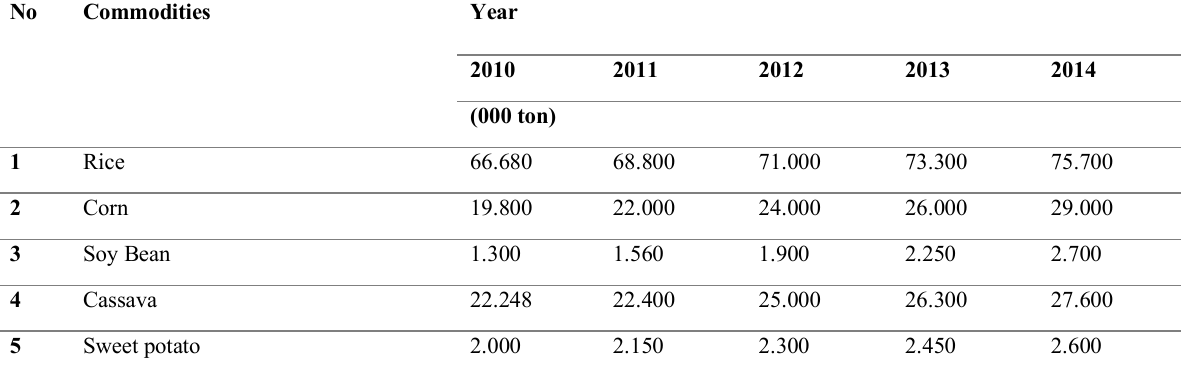
Table 1 : Production target of food crops in Indonesia in 2010-2014